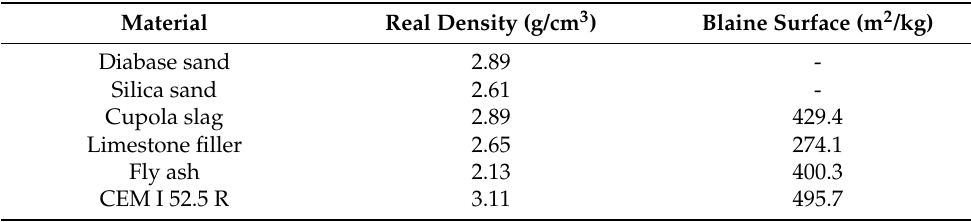
Table 3. Real density and Blaine specific surface of the materials used.